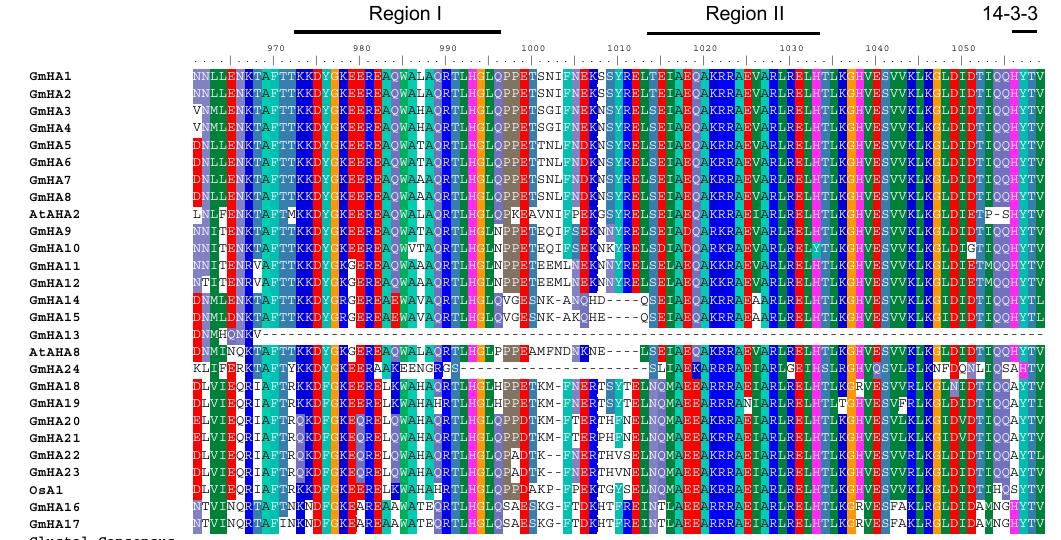
Figure 5. Alignment of the C-terminal regions of 24 soybean PM H + -ATPases and three representative PM H + -ATPases from Arabidopsis and rice (AHA2, AHA8, and OsA1): region I, region II, and the 14-3-3 protein binding site within the C-terminal regions are indicated by lines. Region I and region II in the C-terminal region have been identified to be critical for the autoinhibitory effects on the H + -ATPase. The phosphorylation of penultimate Thr or Ser is required for 14-3-3 protein binding, which results in the activation of H + -ATPases.